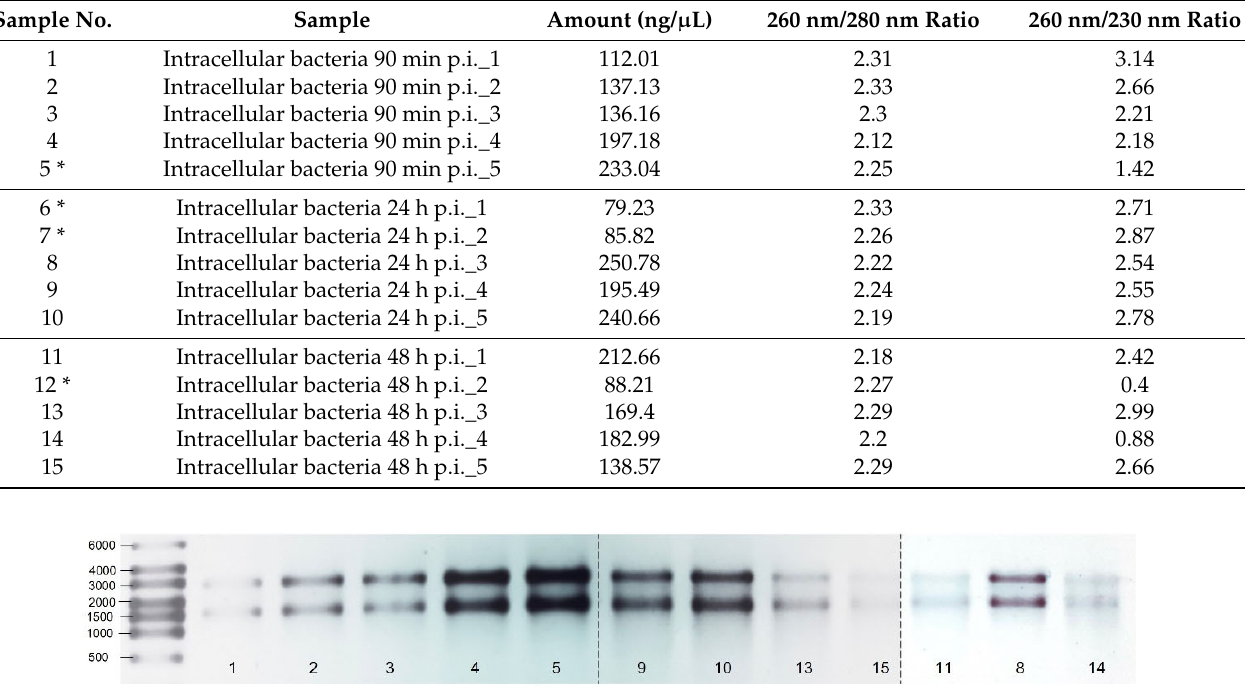
Table 2. List of RNA samples of intracellular S. aureus (gel shown in Figure 3) 90 min, 24 h, and 48 h postinfection (condition II) including the amount recovered and the ratios measured via Nanodrop. * Not enough material for gel electrophoresis was available.